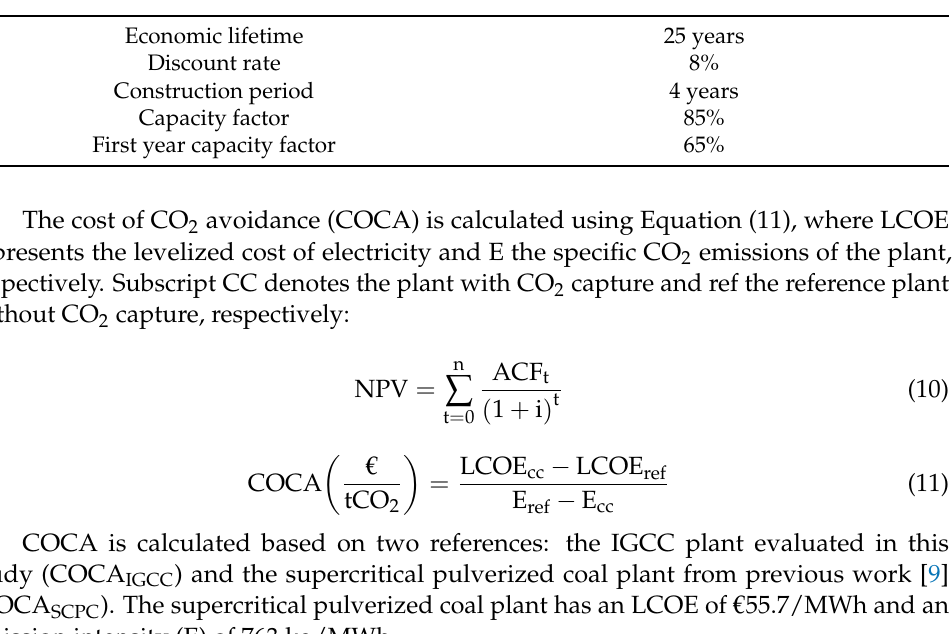
Table 5. Cash flow analysis